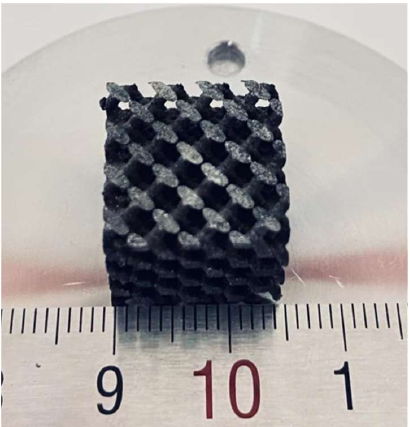
Figure 6. ( a ) The cell fluorescent images and ( b ) cell viability obtained by CCK-8 testing (n.s.).